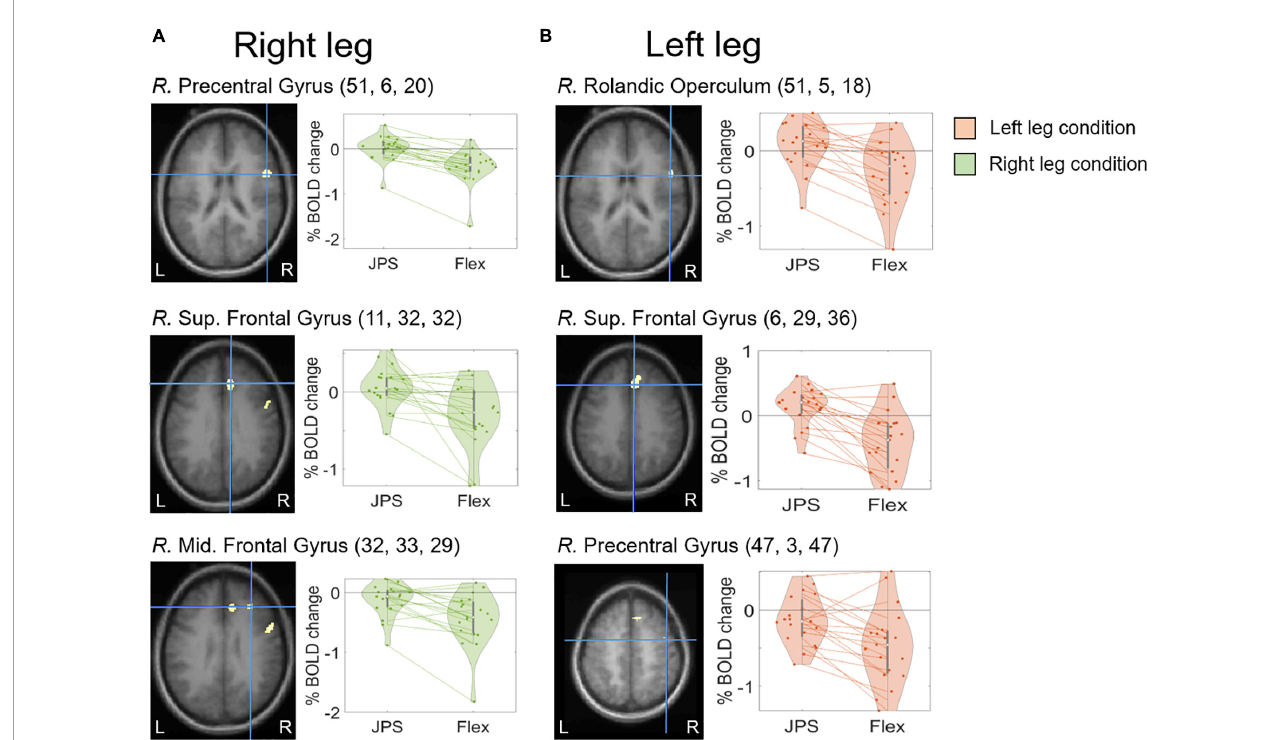
FIGURE3 BOLD response change (%) in the center of peak activation in the brain regions with a significant main effect from [ JPS > Rest ] > [ Flex > Rest ] when analyzing right leg movement (A) and left leg movement (B) separately. The crosshair is centered on the peak activation center for each significant region, visualized on the group mean structural images. Beta representing JPS and Flex are illustrated for both legs. Individual means are depicted by the dots and the corresponding means for each leg are joined together by dotted lines. The MNI coordinates corresponding to peak activation are